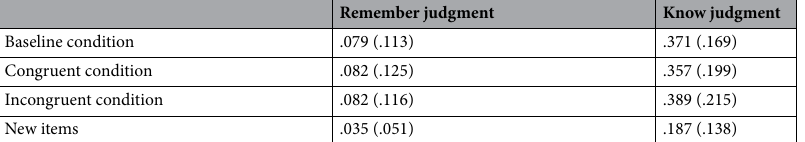
Remember judgment Know judgment Baseline condition .079 (.113) .371 (.169) Congruent condition .082 (.125) .357 (.199) .082 (.116) .389 (.215) .035 (.051) .187 Table 2. Mean proportion of Remember and Know judgments for old items in each condition and for new items during the recognition task in Experiment 2. SD in parentheses.